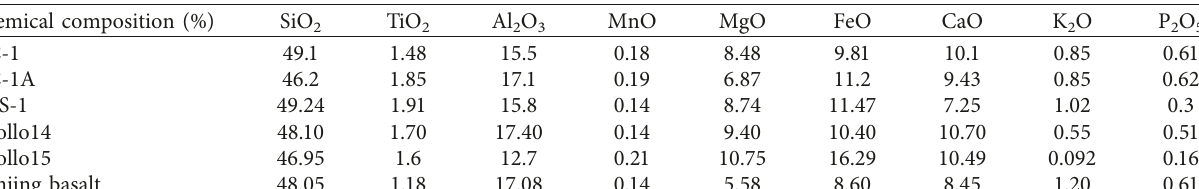
Table 1: Chemical composition of the real lunar soil and lunar soil simulant.